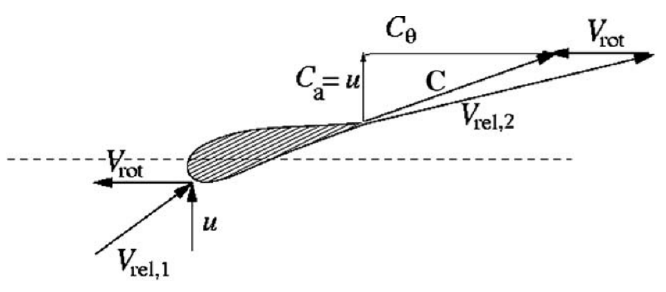
Figure 9. Triangles of velocities on a blade airfoil